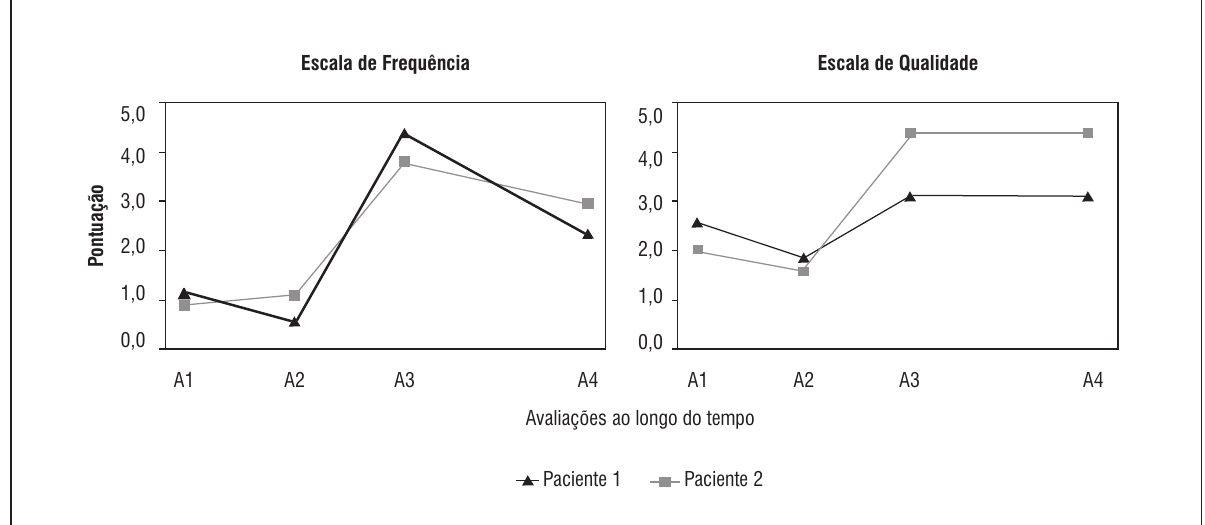
Figura 1 - Pontuação da Escala de Frequência de uso da TMAL e da Escala de Qualidade de uso da TMAL ao longo das avaliações Fonte: Dados da